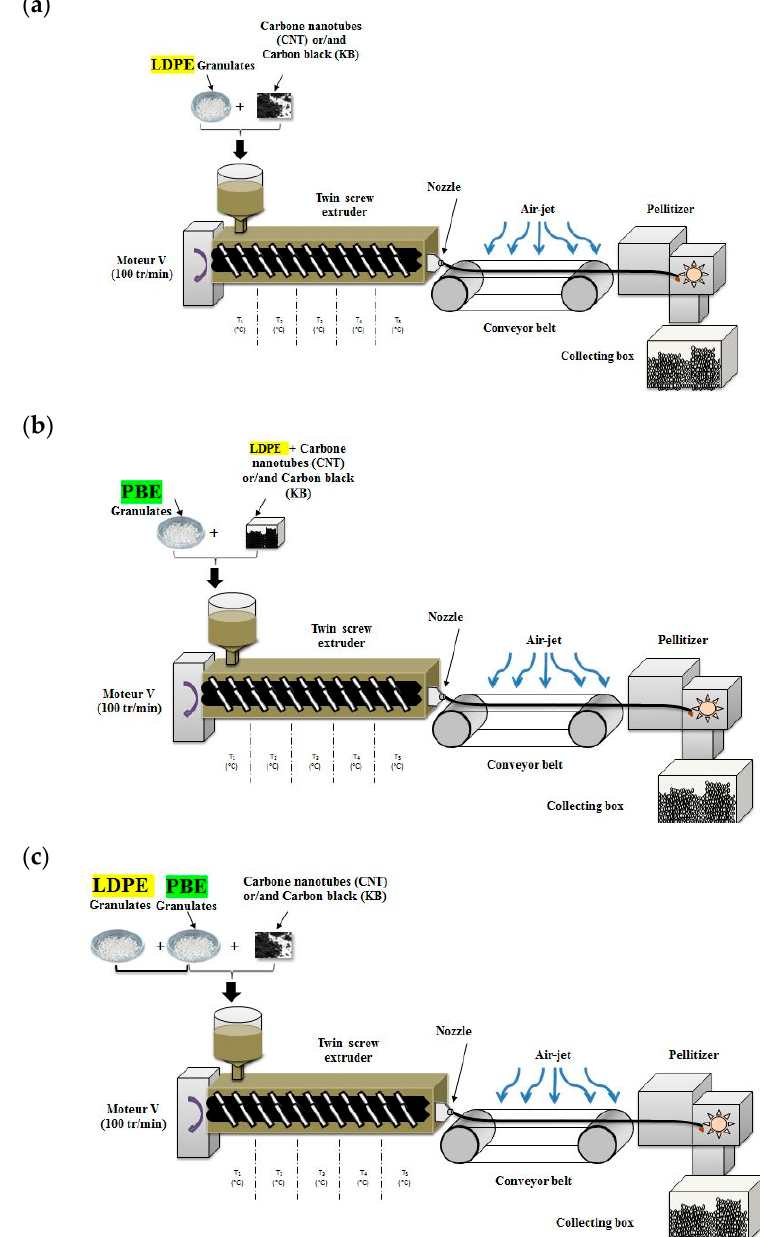
Figure 1. Scheme of the 2-step extrusion ( a , b ) and 1-step extrusion ( c ). The first step of the two-step extrusion is presented in ( a ) and the second step in ( b ). Specific appellation was used in Table 3 to define the polymer blends. For example, 60LDPE KB 10 CNT 5 /40PBE describes 60% of 10% KB and 5% CNT–filled LDPE, blended with 40% of PBE. Similar designations are utilized in the entire Table 3. Temperature profiles (°C) of the extrusion of the LDPE-based CPCs and polymer blends. Sample